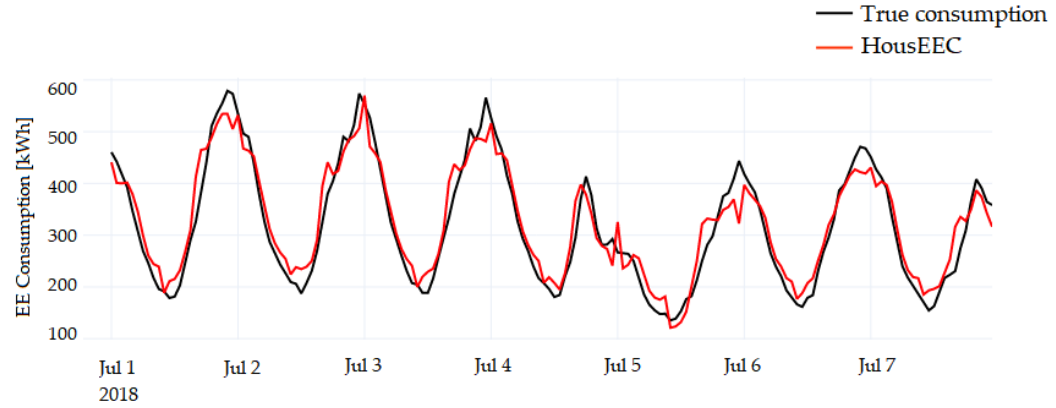
Figure 11. Weekly aggregated EE consumption.